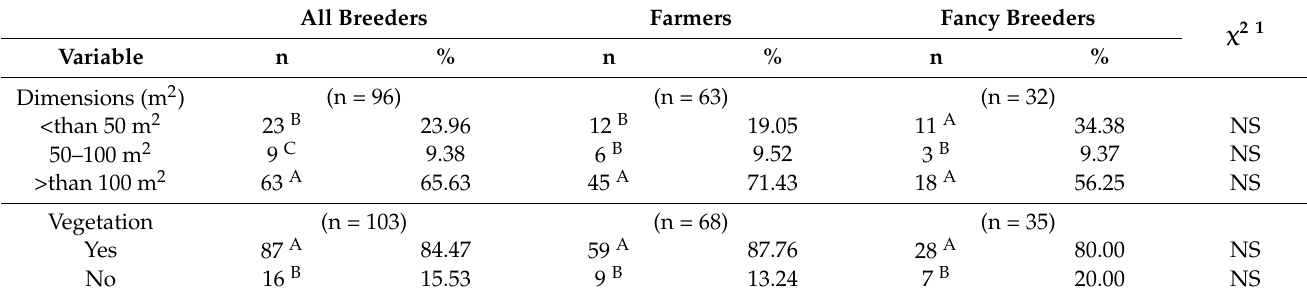
Table 7. Enclosed run and outdoor pen design: responses from all breeders and divided according to breeder category. All